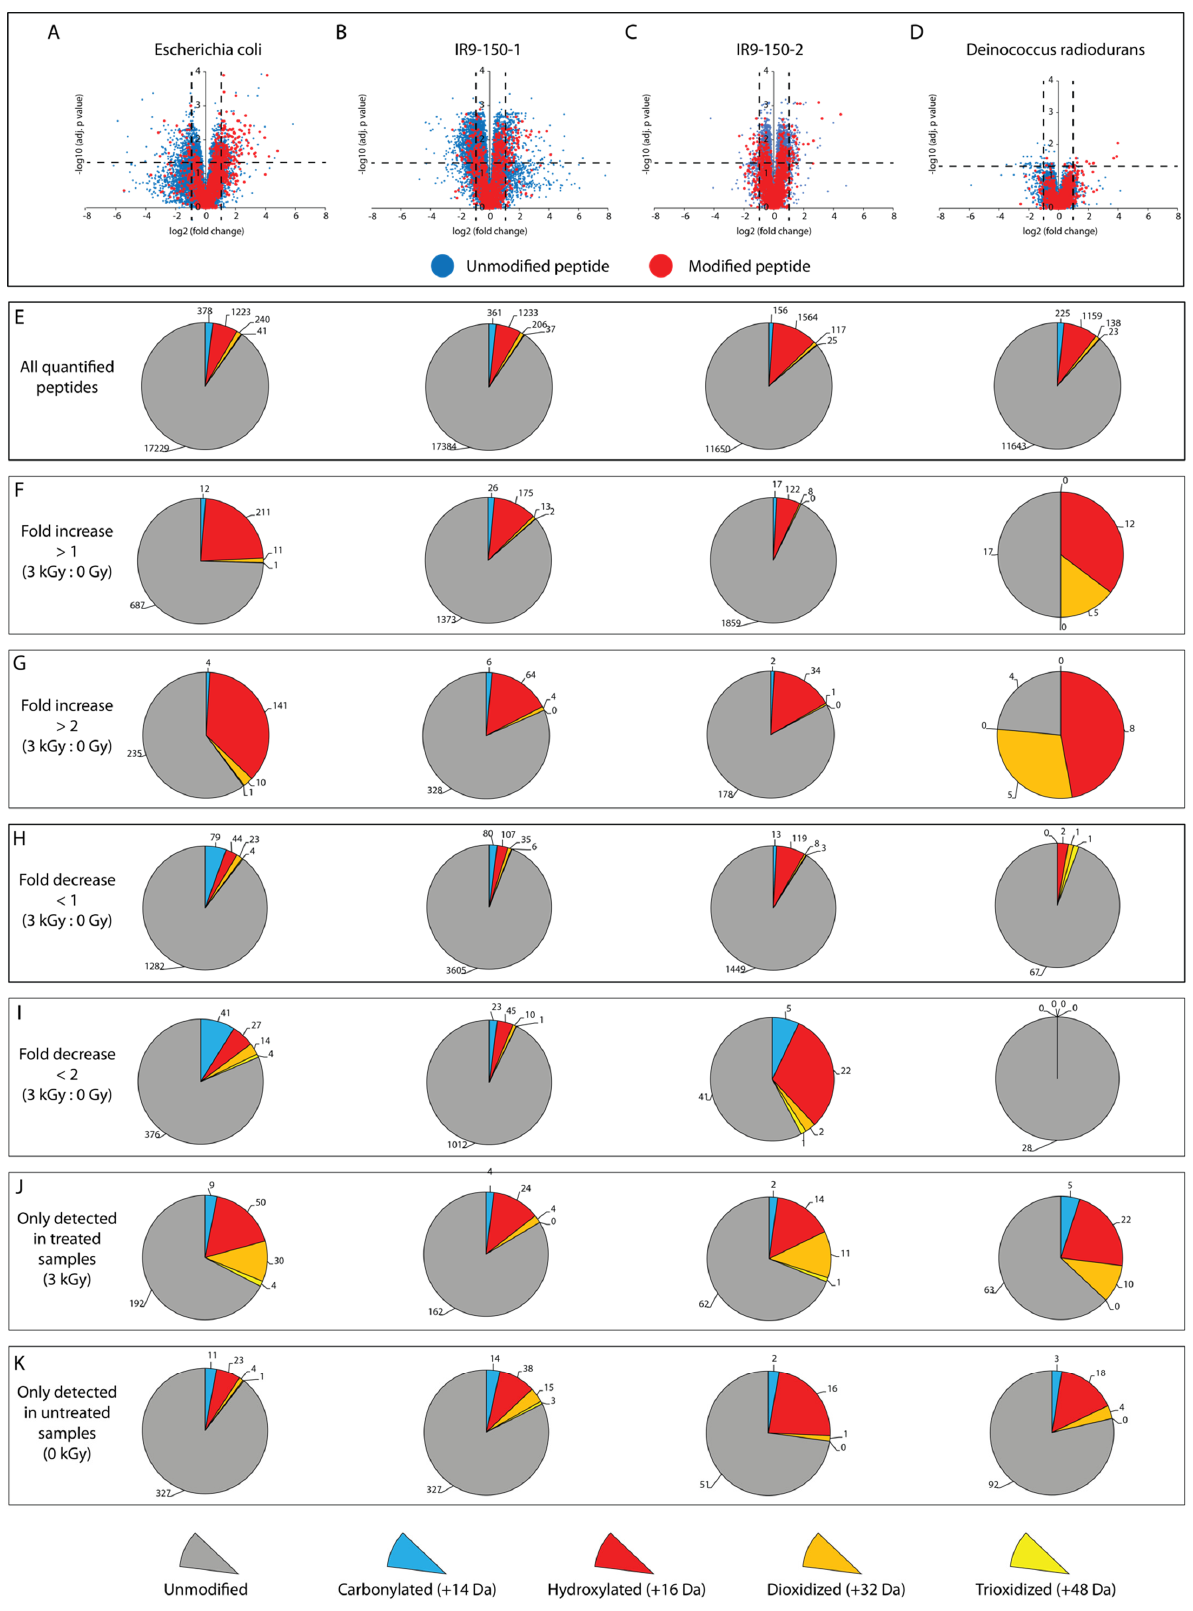
Figure 1. Spectrum of peptide oxidation of cultures irradiated with 3 kGy. ( A ) volcano plots depict the fold increase or decrease (log2 transformed) and statistical significance of the fold change ( − log10 transformed Benjamini–Hochburg